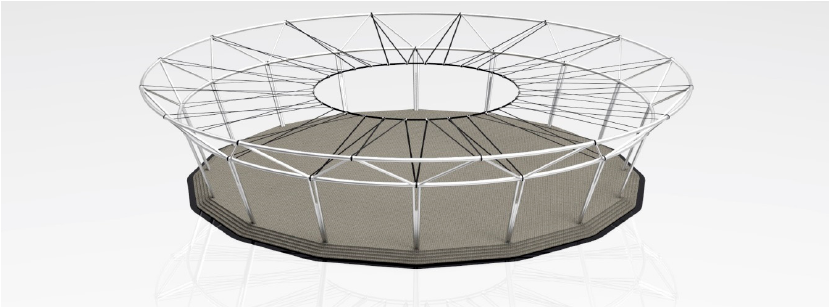
Figure 33. Spoked wheel cable roof with CFRP Continuous Band Winding System.